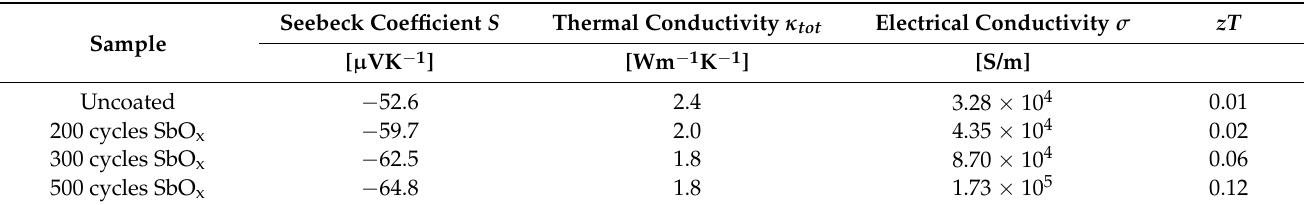
Table 1. Seebeck coefficient S , total thermal conductivity κ tot , electrical conductivity σ and calculated zT value at room temperature (300 K) for uncoated and SbO x -coated sintered samples.